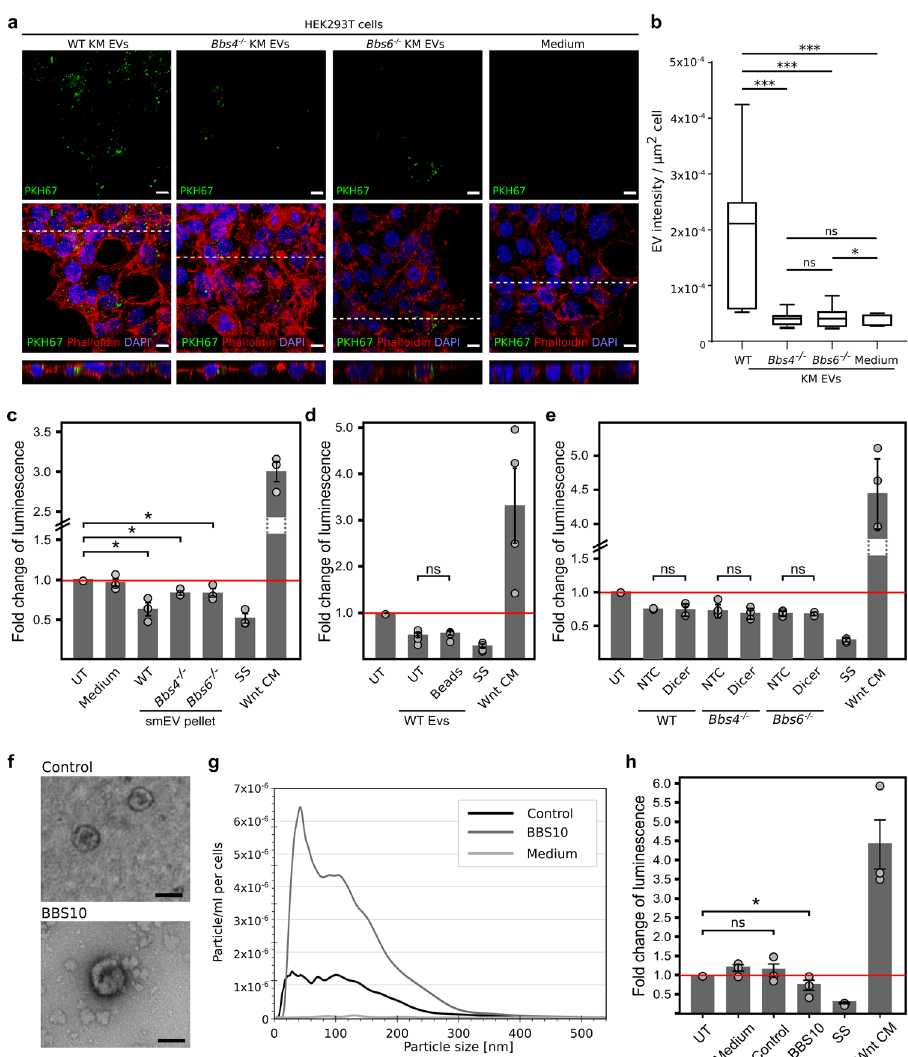
Fig. 5 Small EVs are bioactive and modulate the cellular Wnt response. a HEK293T cells (Phalloidin (cell membrane), DAPI (nuclei)) were able to take up fl uorescently labelled EVs (green dots, PKH67 staining) harvested from ciliated control and mutant KM supernatant. Medium controls show low background staining (scale bar = 25 µ m; fi gure shows representative images from three independent experiments). b Quanti fi cation of fl uorescently labelled EV signal per µ m 2 as shown in ( a ). A signi fi cantly higher fl uorescent signal was detected in HEK293T cells incubated with smEVs derived from control KM cells compared to cilia mutant cells ( N WT, Bbs4 − / − , Bbs6 − / − EVs, medium = 13 analysed images from three independent experiments; two- sided Mann – Whitney U test pWT EV vs. Bbs4 − / − EV = 0.00013; pWT EV vs. Bbs6 − / − EV = 0.000072; pWT EV vs. medium = 1.923E-7; p Bbs4 − / − EV vs. medium = 0.064; p Bbs6 − / − EV vs. medium = 0.05). c Puri fi cation of smEVs and application on TCF/LEF reporter-HEK293T cells. Relative Wnt activity of smEV-treated TCF/LEF HEK cells as measured via luminescence. Vesicle number was measured via NTA. The applied vesicle number was normalised to control EV number. Application of smEVs derived from all ciliated KM cells signi fi cantly decreased the Wnt response of target cells ( N WT, Bbs4 − / − , Bbs6 − / − = four independent experiments; two-sided Mann – Whitney U test pWT vs. TCF = 0.028; p Bbs4 − / − vs. TCF = 0.028; p Bbs6 − / − vs. TCF = 0.047) with no signi fi cant difference between the smEVs derived from control or ciliary mutant samples (two-sided Mann – Whitney U test pWT vs. Bbs4 − / − = 0.713; pWT vs. Bbs6 − / − = 0.551). Medium control shows no difference in Wnt readout ( = three independent experiments). WNT3a N Medium conditioned media was used as a positive control and serum-starved (ss) cells were used as a negative control. d Luciferase assay with control KM EVs puri fi ed via differential centrifugation (UT) and magnetic beads (Beads) showed no difference in the ability to dampen Wnt signalling in target cells ( N WT EV UT, WT EV Beads = fi ve independent experiments; two-sided Mann – Whitney U test pWT EV UT vs. WT EV Beads = 0.690. e Dicer siRNA-mediated knockdown inside control and mutant KM cells prior EV puri fi cation showed no difference in capability to dampen Wnt signalling inside target cells. ( N Dicer NTC, Dicer kd = three independent experiments; two-sided Mann – Whitney U test pWT NTC vs WT Dicer = 0.7; unpaired t test p Bbs4 − / − NTC vs. Bbs4 − / − Dicer = 0.775; p Bbs6 − / − NTC vs. Bbs6 − / − Dicer = 0.893). f Morphological properties of isolated UREC EVs were determined via negative staining followed by transmission electron microscopy and revealed 100 – 150 nm vesicles (scale bars: 100 nm, experiment was done two times). g Nano Particle Tracking Analysis (NTA) measurements from control UREC cells show less smEV release compared to BBS10 cells. Medium control contained no particles ( N Control, BBS10, medium = three independent experiments). h Luciferase assay of isolated UREC EVs showed reduced Wnt signalling in target cells upon application of BBS10 EVs ( N BBS10 = three independent experiments). EVs from control cells showed no effect ( N Control = three independent experiments; unpaired t test pUT vs. BBS10 EV = 0.05; pUT vs. control EV = 0.385). b Boxplots show median, interquartile range, and maximum and minimum within 1.5 interquartile range. c – e , h Data are presented as mean values + / − SEM. n.s., P > 0.05, * P ≤ 0.05, ** P < 0.01, *** P <